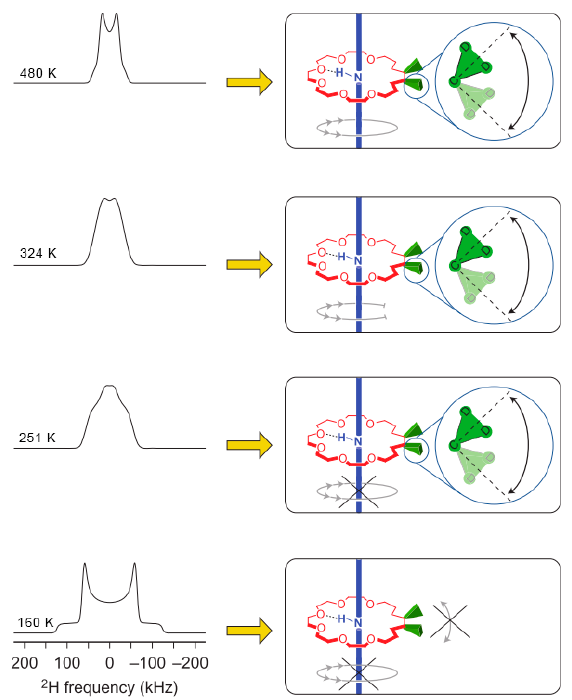
Figure 16. Simulated 2 H NMR line shapes of the metal–organic rotaxane framework UWDM-1 at different temperatures. The corresponding models are shown on the right-hand side. Reproduced with permission from [45]. Copyright Nature Publishing Group, 2012.